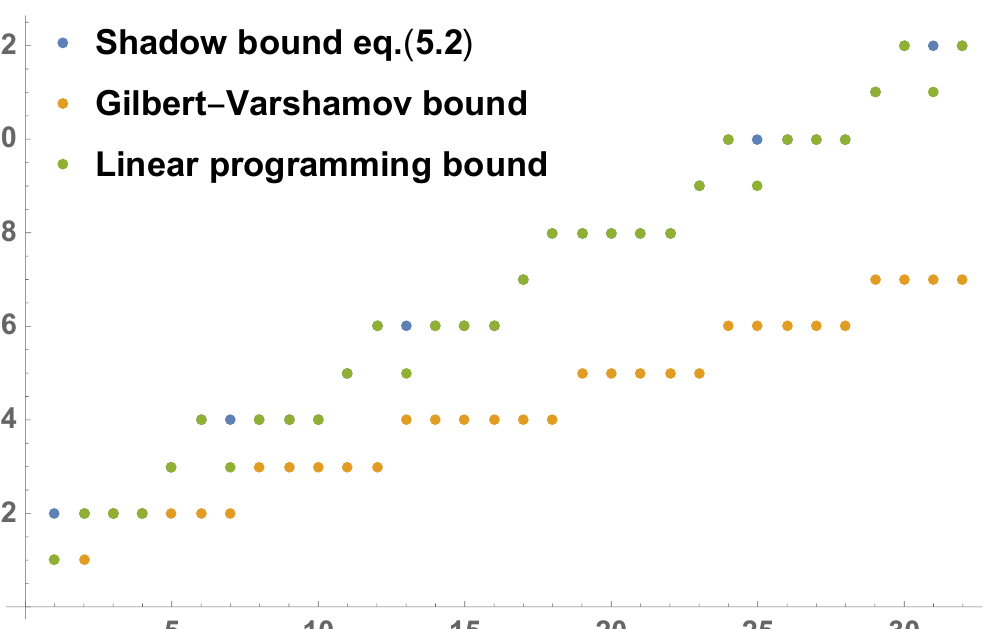
Figure 1 . Upper and lower bounds on the maximal Hamming distance for self-dual stabilizer codes. Blue: “shadow” upper bound (5.2) found by Rains [59]. It is an analytic constraint following from the linear programming bound. Green: linear programming upper bound solved numerically for n ≤ 32 . For n ≤ 18 it coincides with the actual maximal d for the given n , but it is known to be conservative for n = 19 . Yellow: Gilbert-Varshamov lower bound obtained from the refined enumerator polynomial averaged over all B -form codes